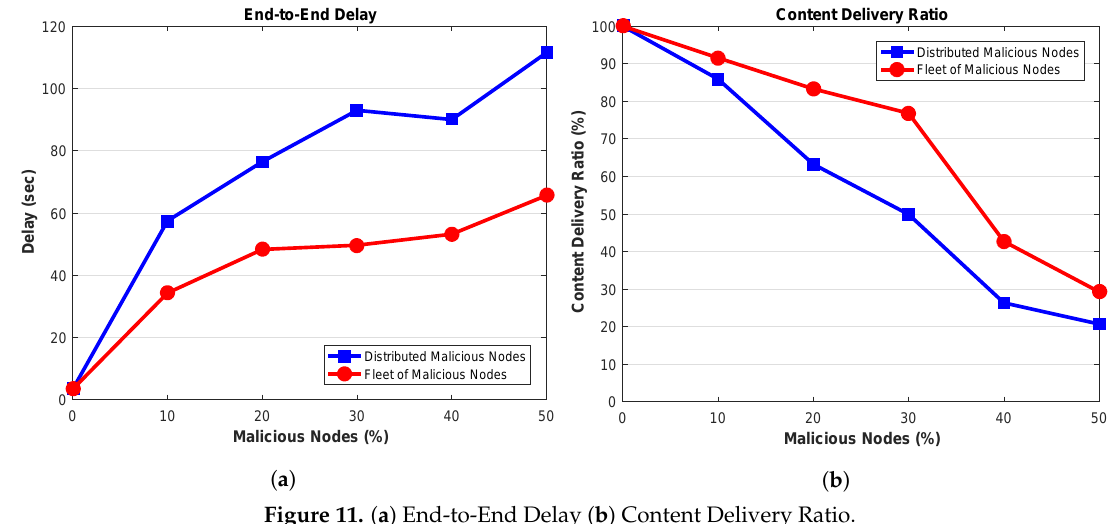
Figure 11. ( a ) End-to-End Delay ( b ) Content Delivery Ratio.